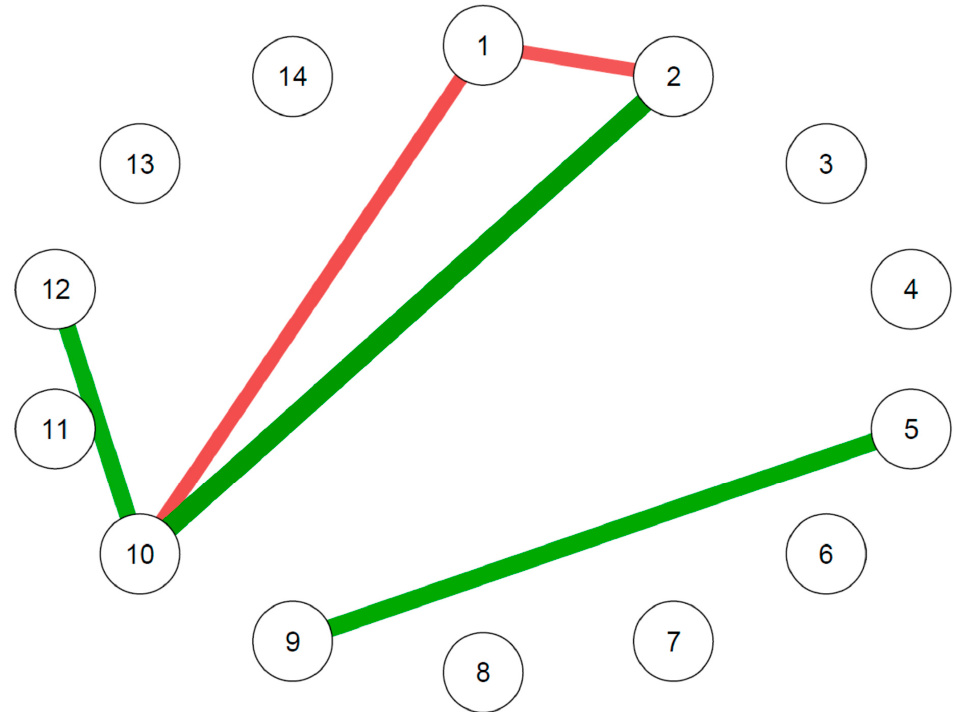
Figure 3. Differences of personality networks between those with and without MDE at follow-up. 1: TAS-20 Difficulty identifying feelings; 2: TAS-20 Difficulty describing feelings; 3: TAS-20 Exter-